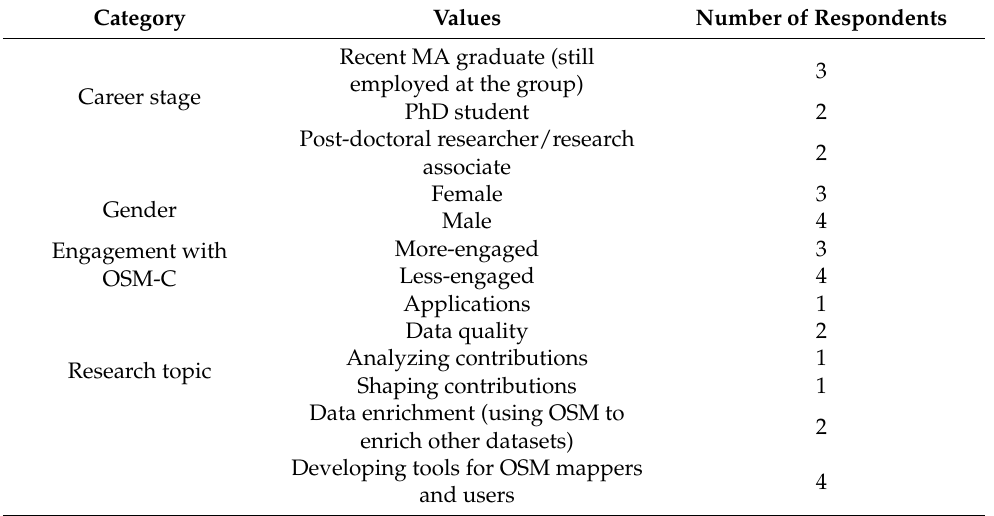
Table 2. Respondents’